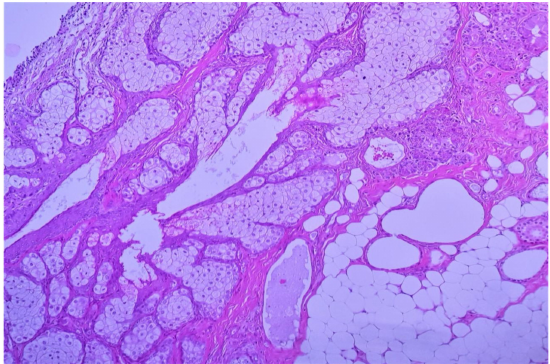
Figure 6. Mixture of mature, benign tissues most common squamous epithelium, and sebaceous glands; fibroadipose tissues, cartilage, or respiratory epithelium may also be found (10 × HE). (Cour- tesy of Dr. R.